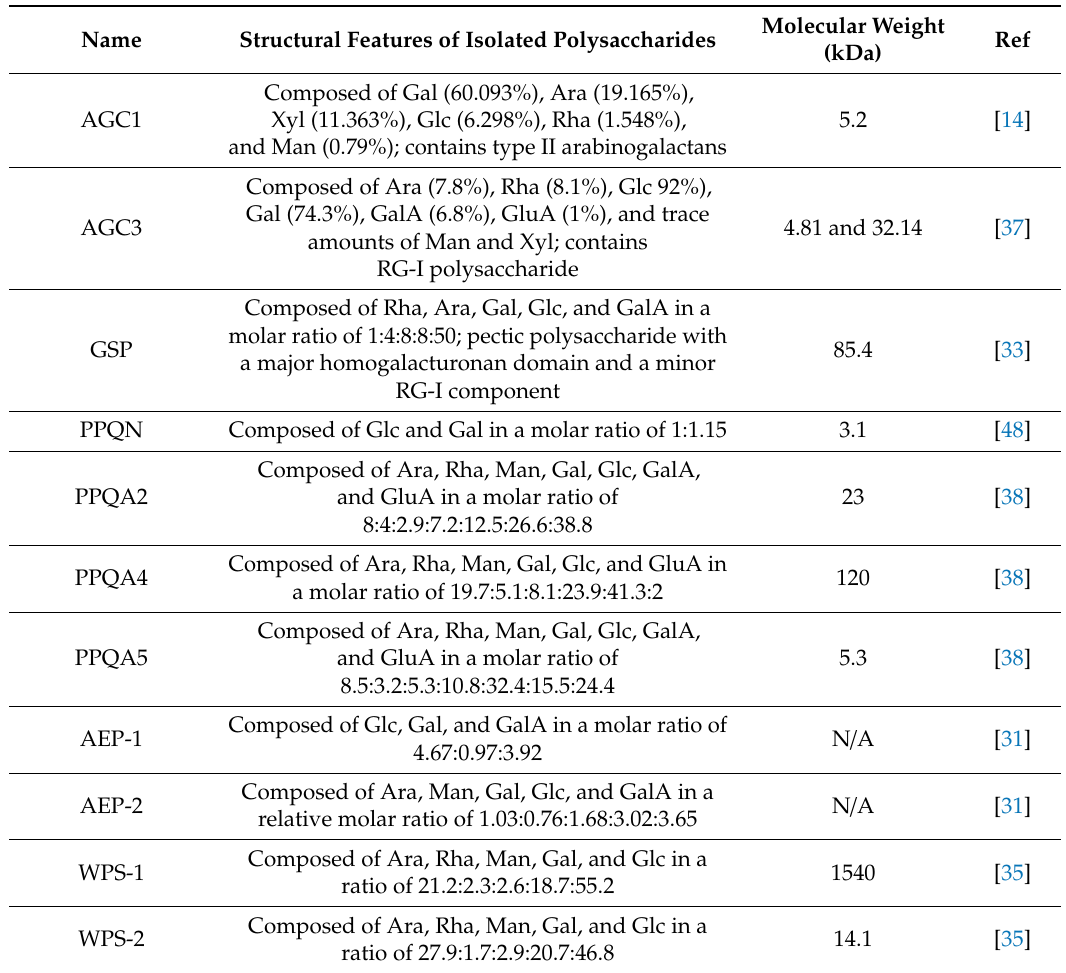
Table 1. Structural features of polysaccharides isolated from di ff erent sources of North American ginseng